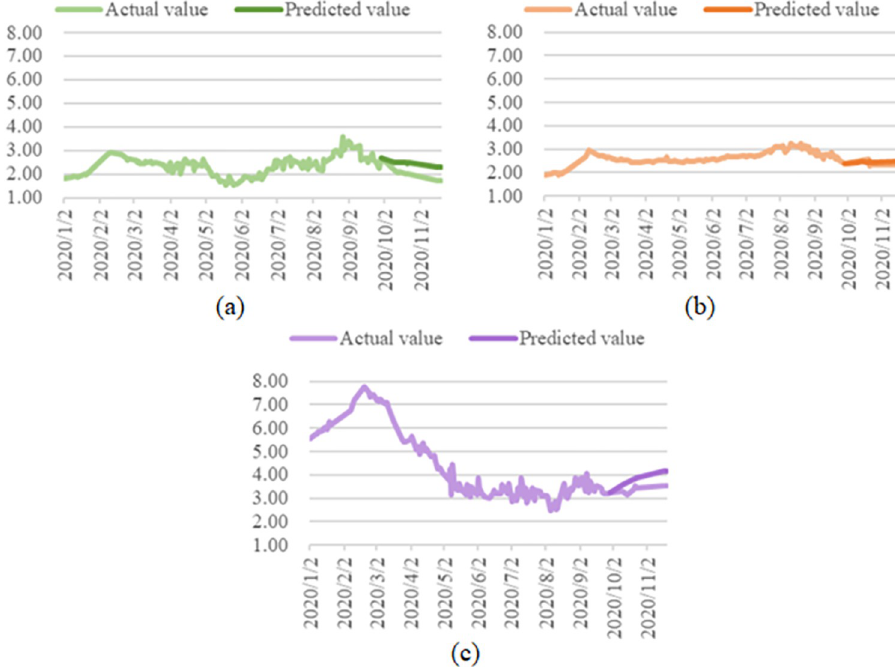
Fig 18. Average price forecast for cabbage (a), carrot (b), and eggplant (c).